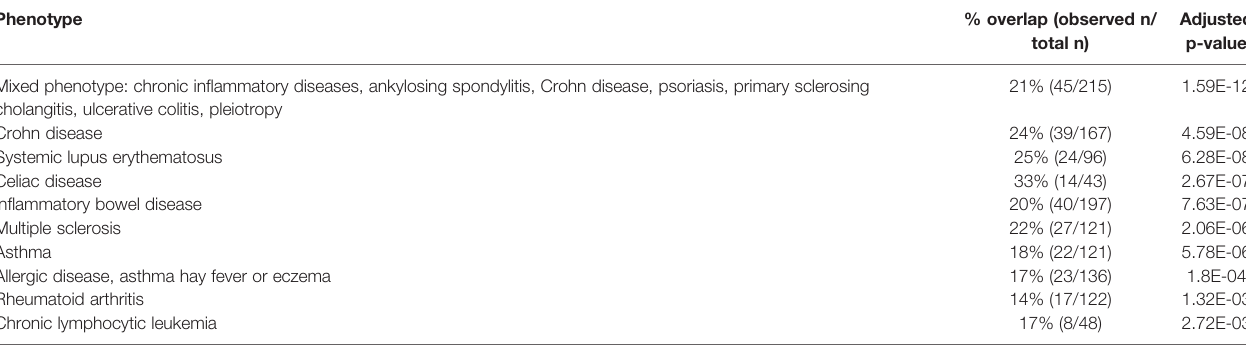
TABLE 2 | Regulatory element locus intersection (RELI) analysis (191) of the overlap between RUNX1 Jurkat T cell chromatin immunoprecipitation sequencing (ChIP- seq) peaks and disease-risk single-nucleotide polymorphisms (SNPs) in the blood and immune system.